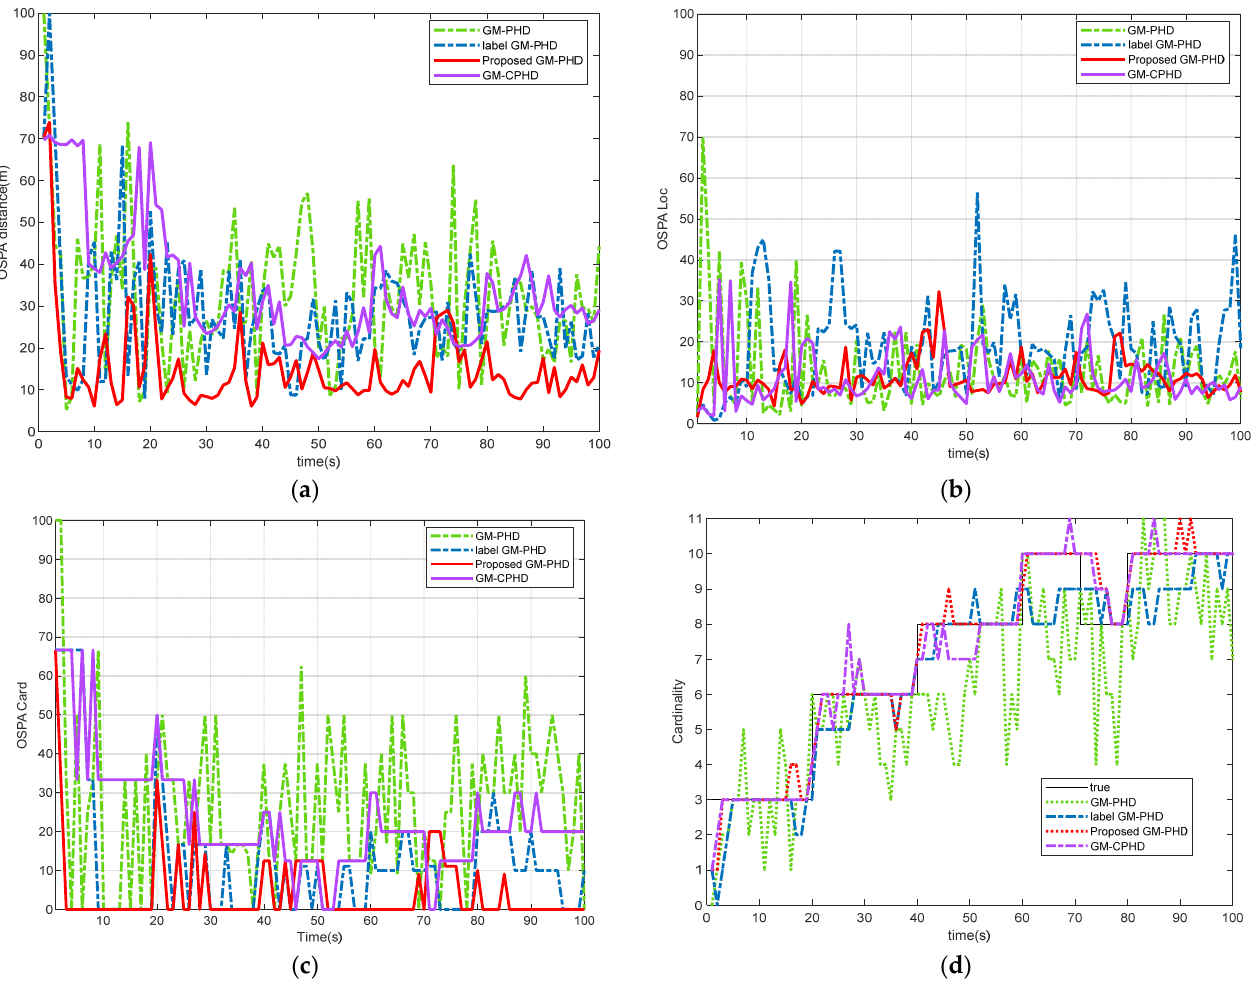
Figure 4. Performance comparison of different algorithms in dense clutter and low detection prob- ability environment: ( a ) OSPA distance comparison; ( b ) OSPA Location comparison; ( c ) target car- dinalities estimation error; ( d ) estimated cardinalities of targets.